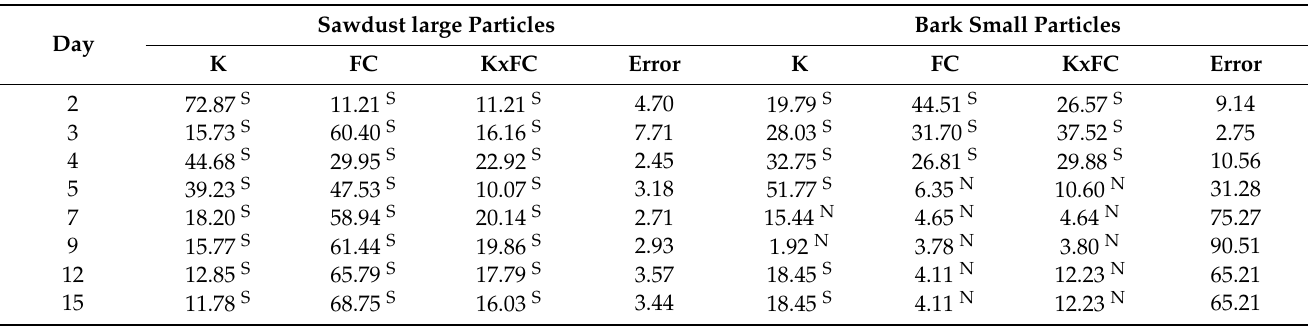
Table 6. Percentage of the compatibilizer influence, filler fraction and their interactions influencing the mold growth on HDPE composites.